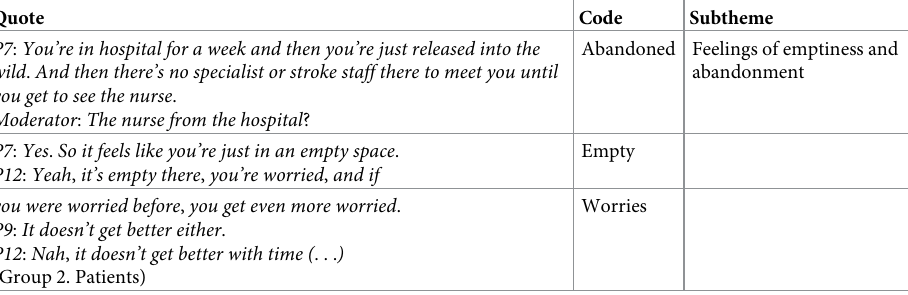
Table 1. An example of a coding tree.